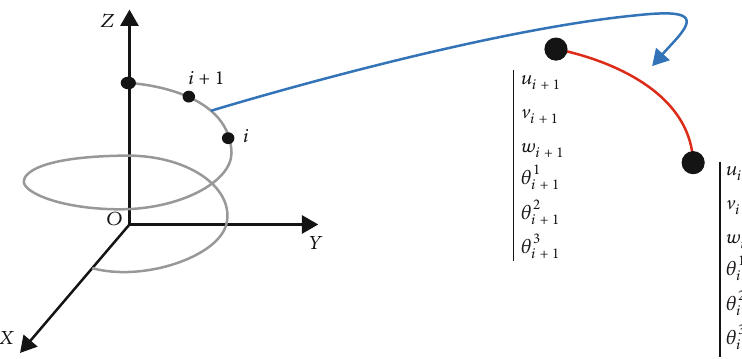
Figure 3: Discretization of the middle line into curvilinear fi nite